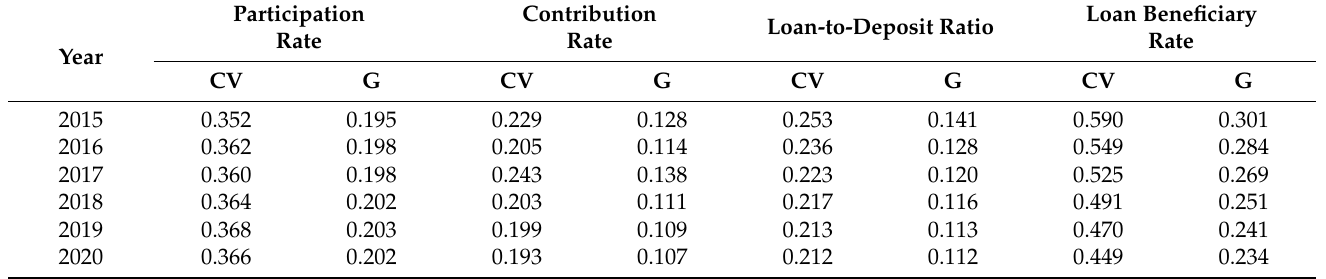
Table 4. The variation coefficient and Gini index of the HPF equity performance from 2015 to 2020.